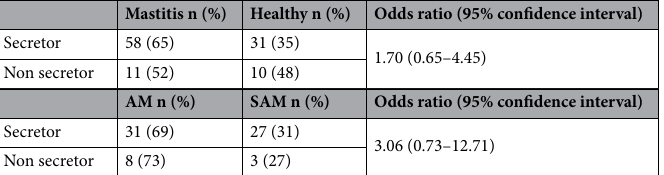
Table 1. Incidence of mastitis and type of mastitis (acute [AM] or subacute [SAM]) among participant women according to the Secretor